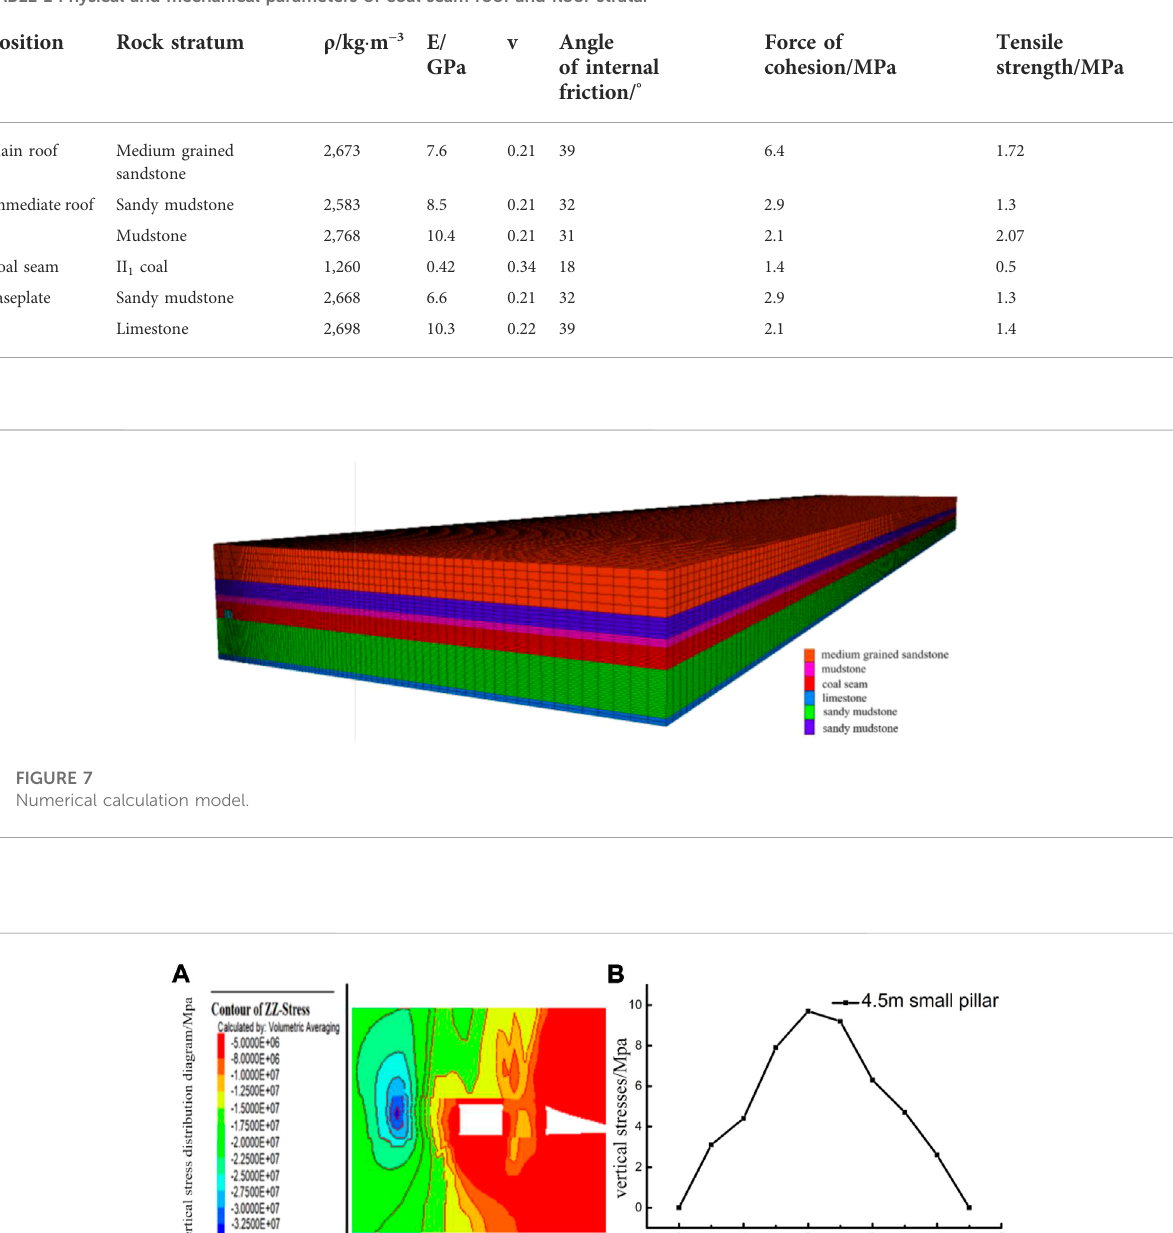
Frontiers in Earth